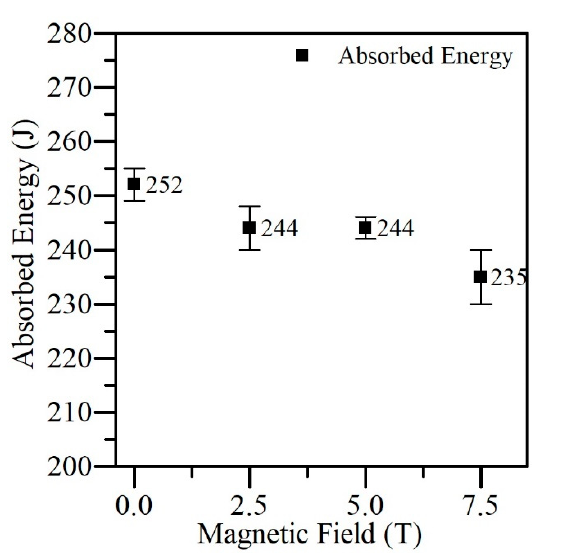
Figure 11. Energy absorbed with the variation of the external magnetic field obtained by the Charpy test.